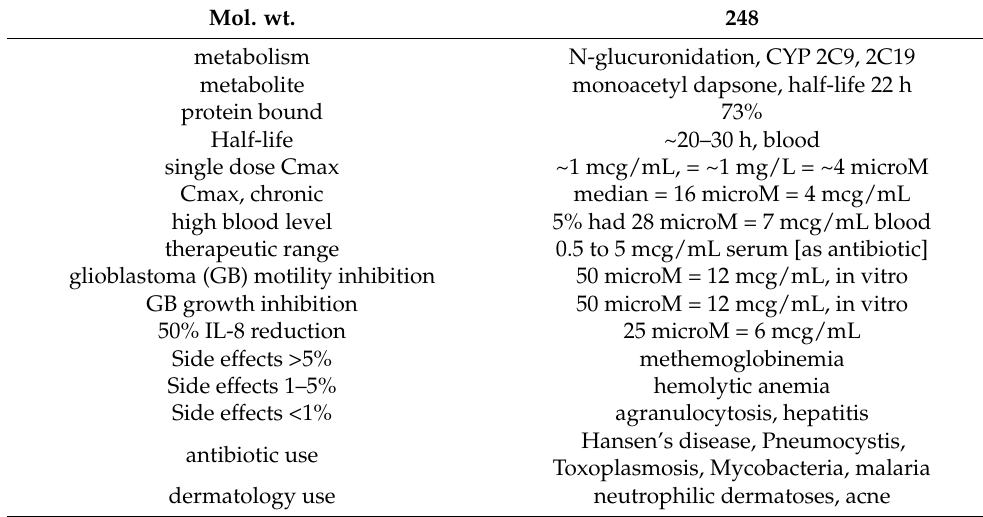
Table 1. Basic pharmacological parameters of dapsone. For references see text and Zuidema et al. Mol.